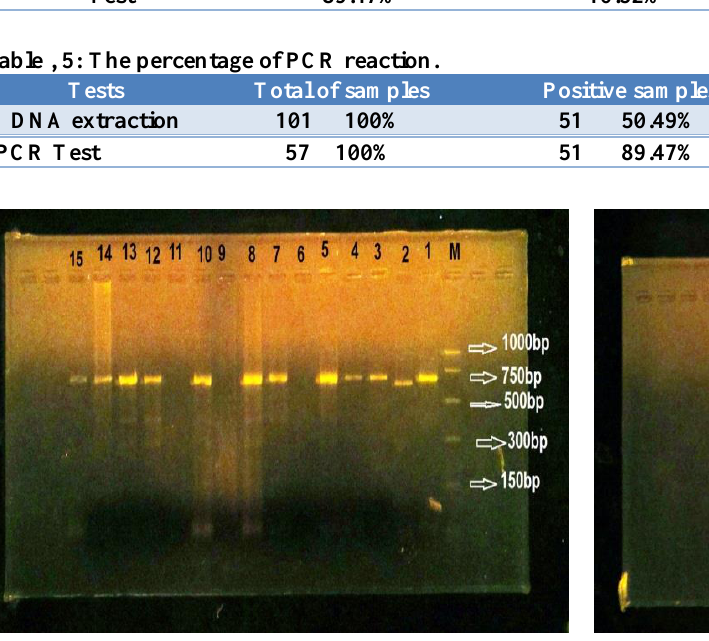
Figure, 2: typical PCR products of S. equi subsp. equi with specific oligonucleotide primers respectively lanes 1,2,3 show the PCR products of S. equi with sized 677bp by using SeM primers. Lanes 13, band of 325bp length amplified using